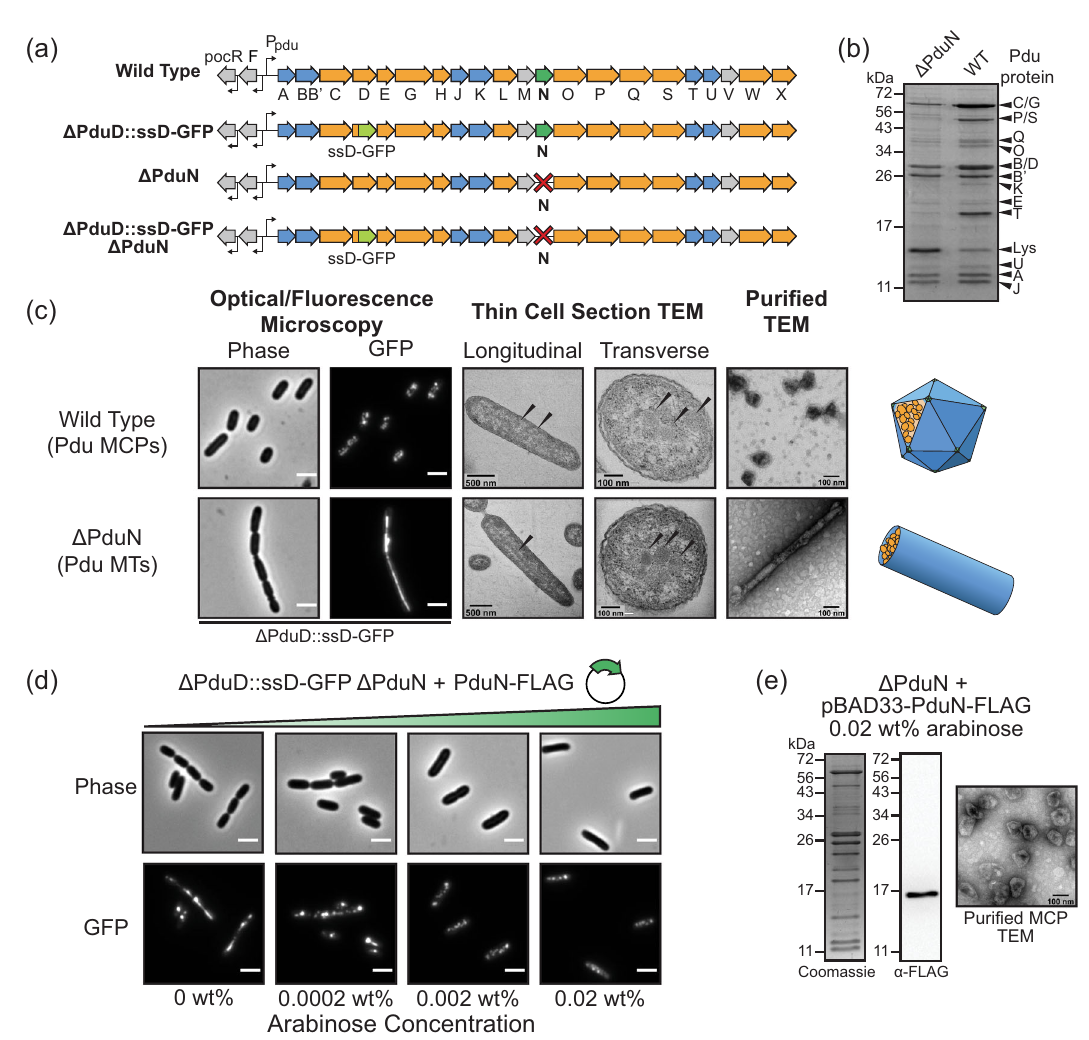
Fig. 2 Characterization of structures formed in the absence of PduN. a Depiction of different pdu operon genotypes used in this fi gure. b Coomassie- stained SDS-PAGE of puri fi ed Pdu MTs ( Δ PduN) and Pdu MCPs (WT) comparing the protein content in these puri fi ed structures, where labels indicate the Pdu protein the band corresponds to (i.e. C/G for PduC/PduG), except for Lys, which indicates lysozyme. c Comparison of structures formed in Pdu MCP- forming strains (WT) and Pdu MT-forming strains ( Δ PduN). Scale bars in optical and fl uorescence micrographs are 5 µ m. d Phase contrast and GFP fl uorescence micrographs showing the impact of increased PduN-FLAG expression on the formation of Pdu MT structures versus closed Pdu MCP structures, where increasing arabinose concentration correlates with increasing expression of the PduN-FLAG protein off the pBAD33 plasmid. Scale bars in optical and fl uorescence micrographs are 5 µ m. e Coomassie-stained SDS-PAGE, anti-FLAG western blot, and negatively stained TEM on Pdu MCPs puri fi ed from a pduN knockout strain supplemented with PduN-FLAG off a plasmid. Source data for ( b ) and ( e ) are provided as a Source Data fi le. Similar results to those reported in ( b – e ) were observed across three independent biological replicates, except for TEM imaging of thin cell sections, which was performed on multiple cells in a given biological sample, but not with biological